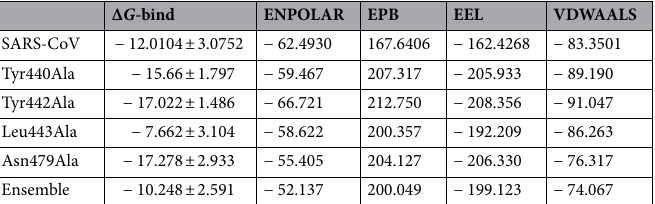
Δ G- bind ENPOLAR EPB EEL Table 5. The MM-PBSA binding energies (kcal·mol −1 ) for selected alanine scanning in residue Tyr453, Leu455, Phe456, Gln493 for SARS-CoV-2.